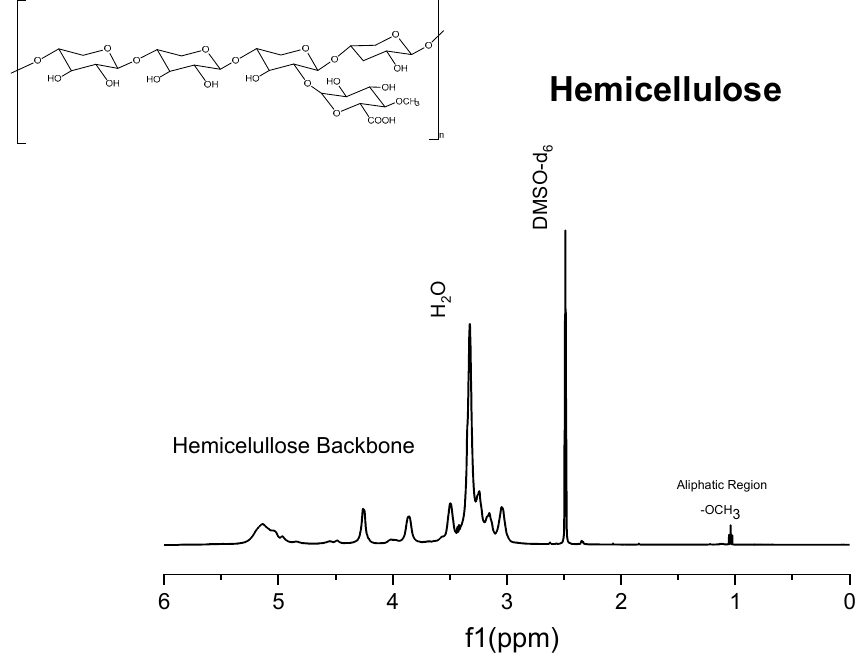
Figure 7. 1 H NMR spectrum of commercial xylans.